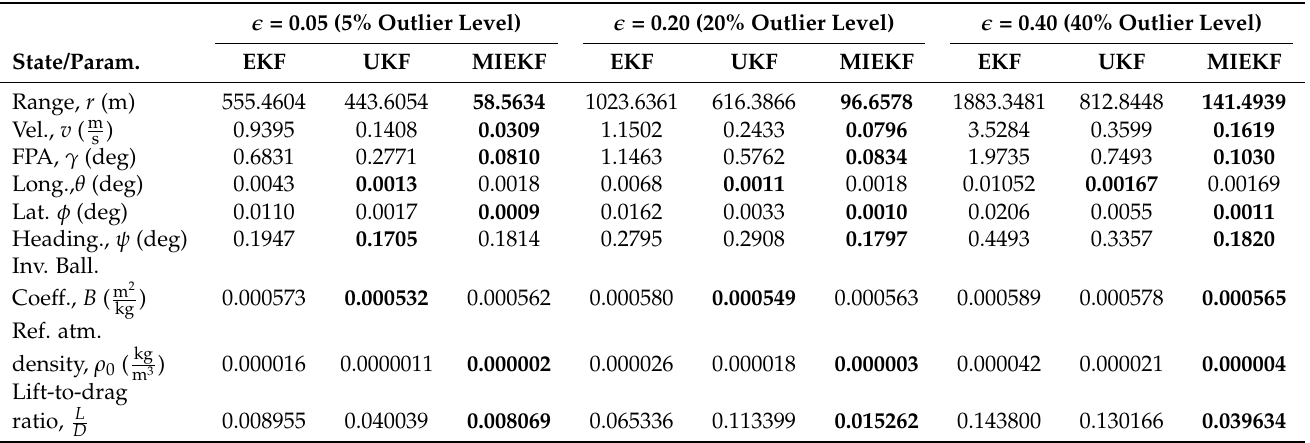
Figure 18. For (cid:101) = 0.4: ( a ) Atmospheric density variation with altitude. ( b ) Velocity variation with altitude. ( c ) Relationship between velocity and flight path angle. It is noteworthy that MIEKF-based estimates are not affected by outliers and match the true relationships quite closely, while alternative approaches exhibit noticeable errors in estimation. Table 3. Filter performance comparison based on RMSE